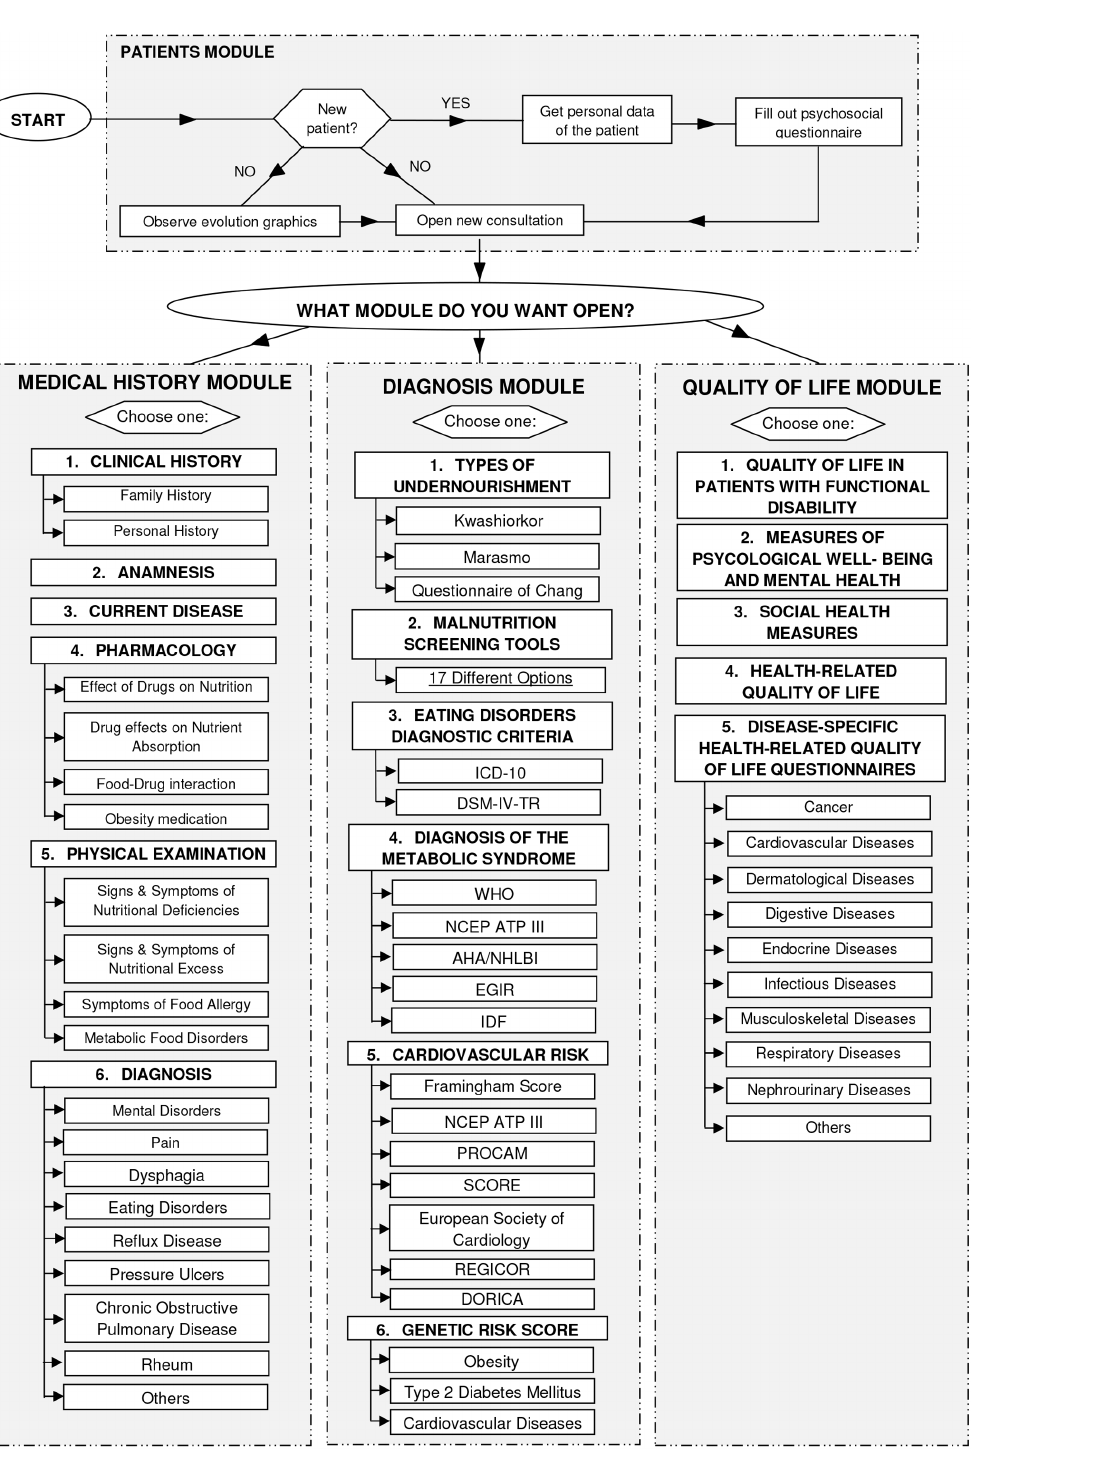
Fig 1. The information flow of the Computer Assisted Instruction.